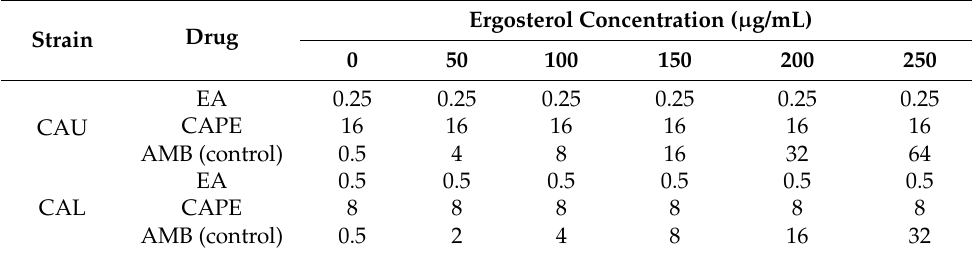
Table 3. MIC values ( µ g/mL) of EA, CAPE, and amphotericin B against C. auris CAU-04 and